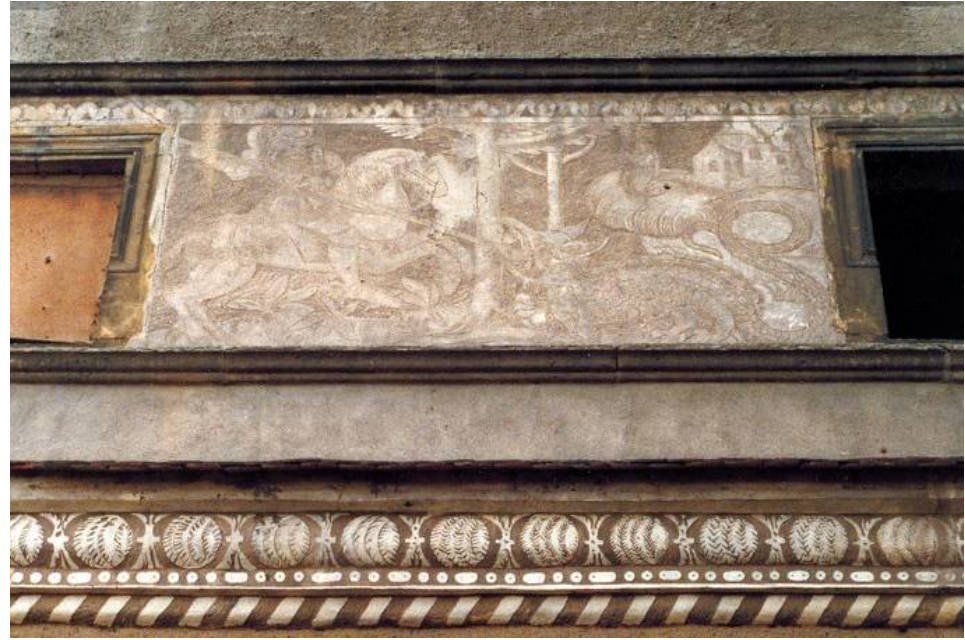
Figure 31. From the rich figural decoration of the manor house in Pawłowice, showing only the scene of the Fight of St. George with the dragon. Author’s photo, 2003.